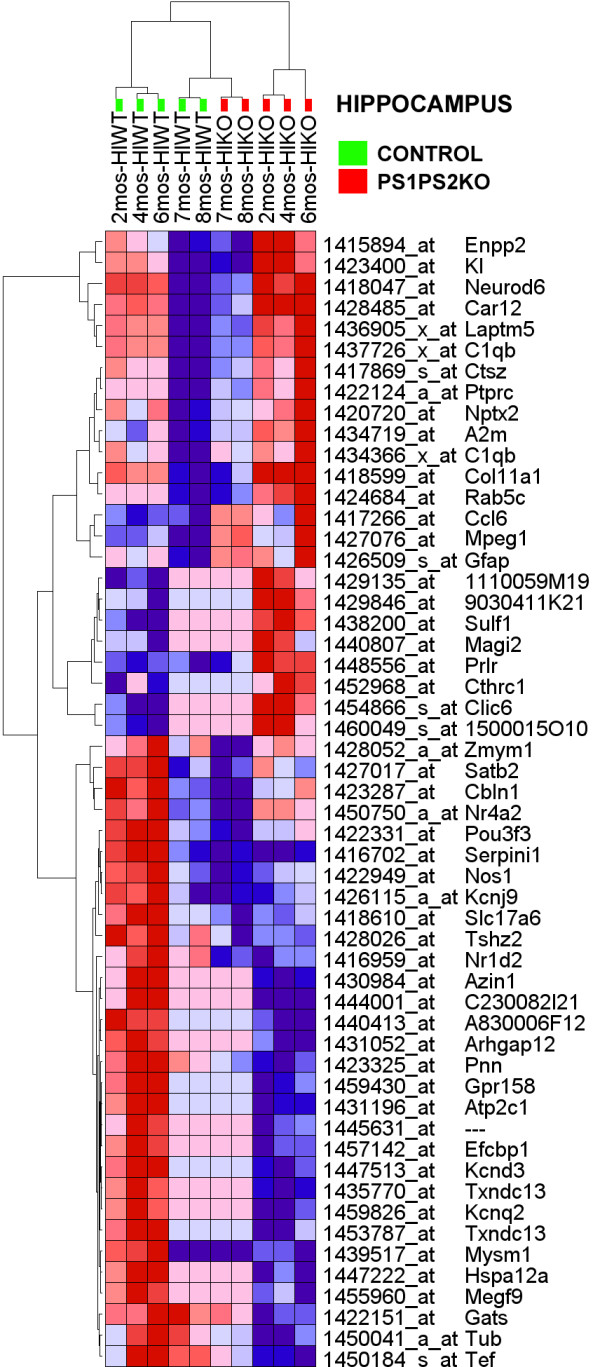
Hierarchical clustering of genes that show differential expression in the HC of PSKO and CNT mice. The numerical data are presented in Additional File 5. Gene probes are clustered in rows (denoted by symbols and probe identifiers), while microarrays are clustered in columns (denoted by sample identifiers). Figure layout similar to that in Figure 2. Note that the frontal cortical PSKO and CNT samples, regardless of developmental age, cluster on different ends of the dendrogram.